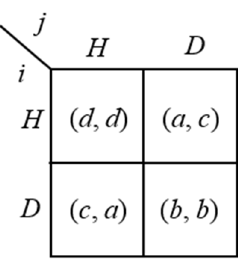
Figure 11. Hawk-Dove Game as original game G .